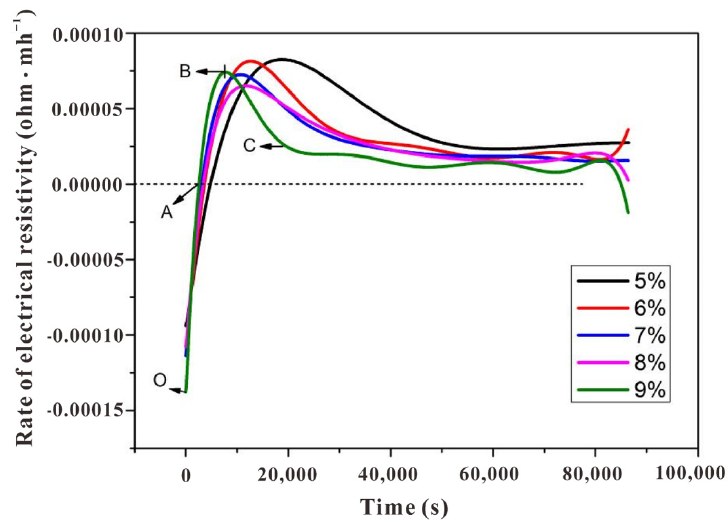
Figure 3. Differential electrodeless resistivity curves of a slag-based geopolymer with different alkali contents.